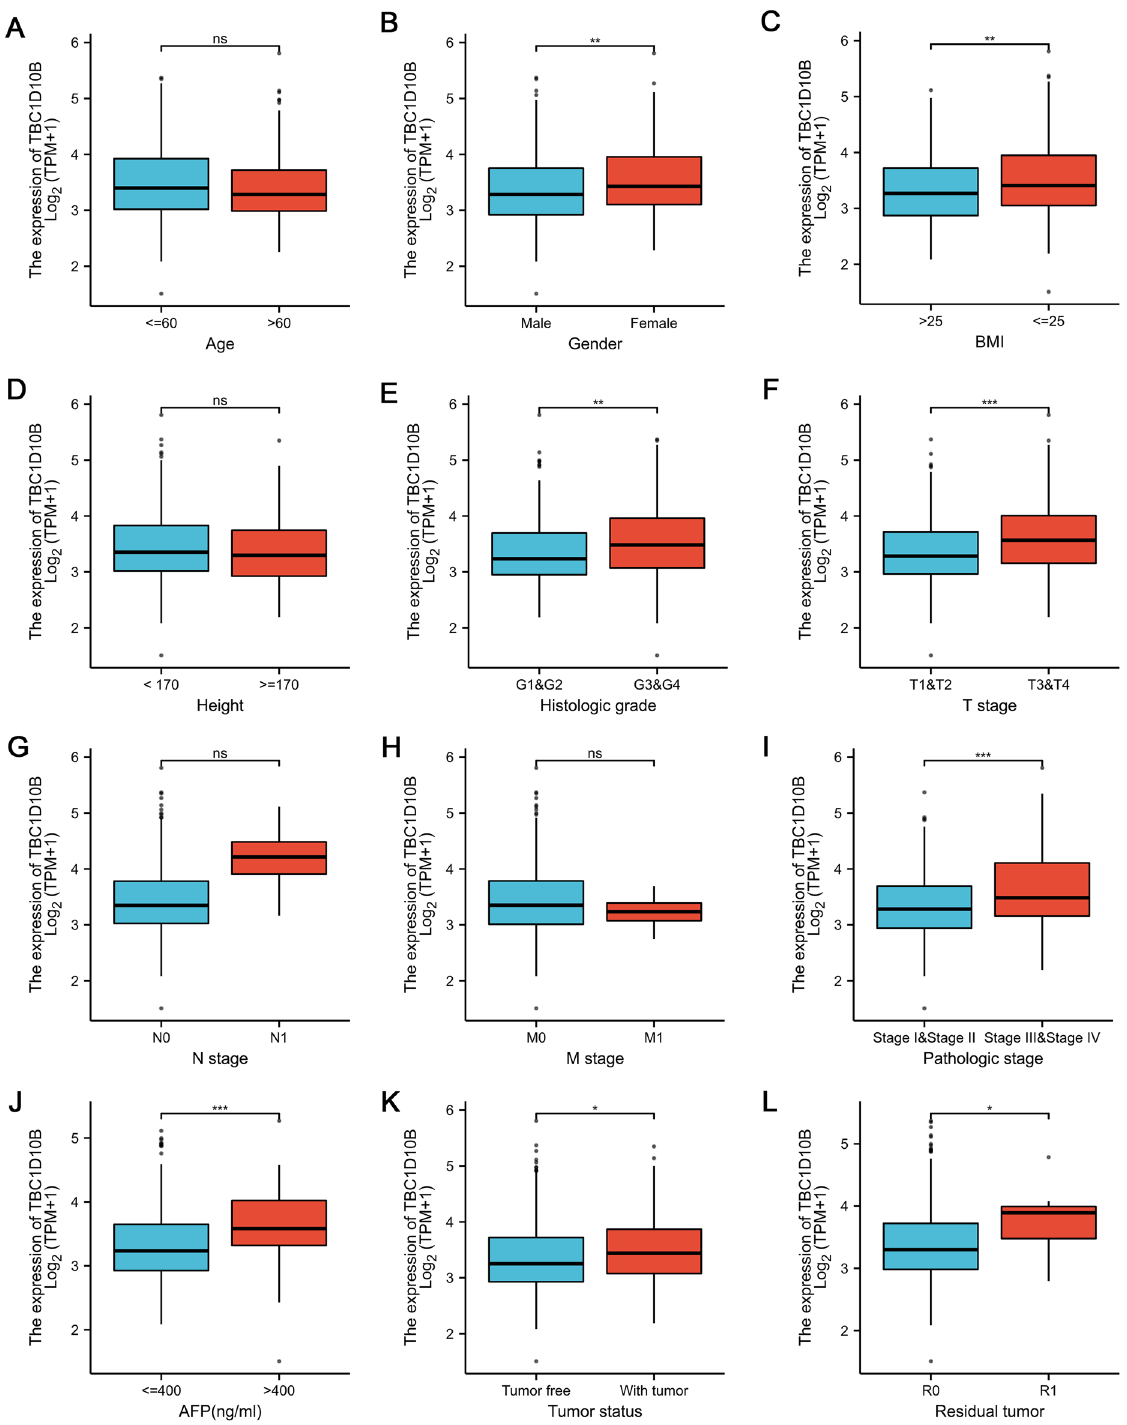
Figure 4. Association between TBC1D10B mRNA levels and clinicopathological features in LIHC. Based on the analysis of TCGA data, the expression levels of the TBC1D10B gene were positively correlated with gender was female ( A ), body mass index greater than or equal to 25 ( C ), high histologic grade ( E ), T stage ( F ), pathological stage ( I ), AFP level greater than 400 ng/mL ( J ), tumor status ( K ) and residual tumor ( L ), but not with age ( A ), height ( D ), N stage ( G ) and M stage ( H ). ns no significance, * P < 0.05, ** P < 0.01, *** P <